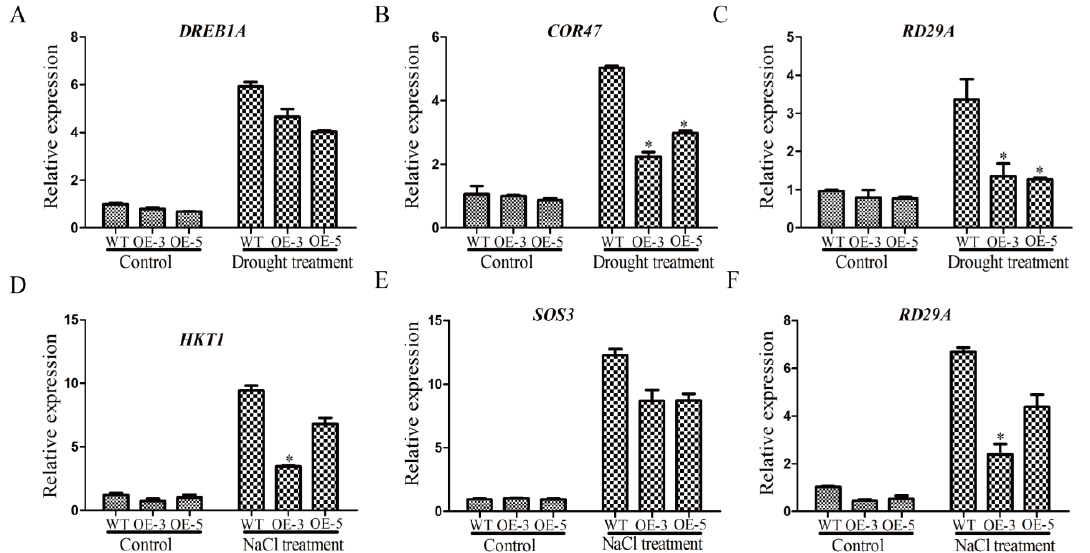
Figure 9. The expression levels of stress-related marker genes. Drought stress-related marker genes were tested, including DREB1A ( A ), COR47 ( B ), and RD29A ( C ). Salt stress-related marker genes were tested, including HKT1 ( D ), SOS3 ( E ), and RD29A ( F ). Independent t-tests demonstrated that there was a significant difference (* p < 0.05).